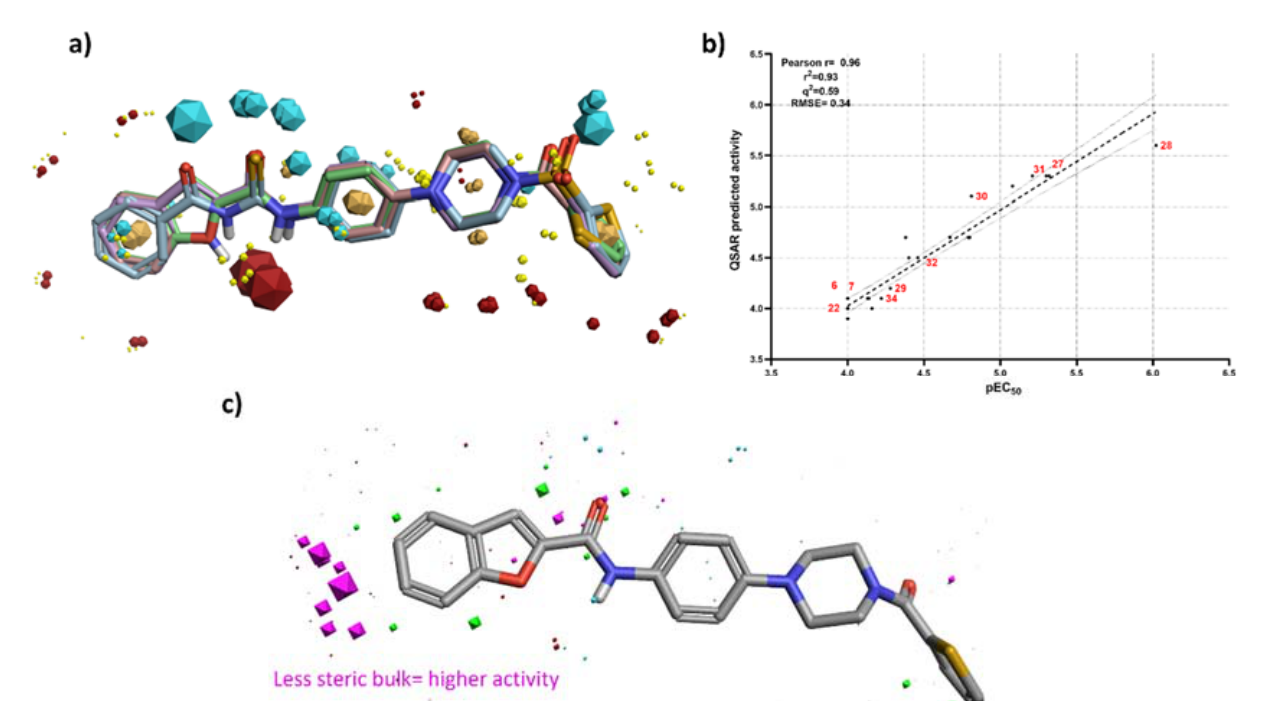
Figure 4. 3D-QSAR results for human norovirus. ( a ) Pharmacophore template with the respective molecular field points generated using compounds 4, 27, 28 and 30; ( b ) Plot of experimental (expressed as pEC 50 ) vs. predicted activity of the 3D-QSAR model; ( c ) The visual representation of the coefficients and variance field points modulating the bioactivity in the derived 3D-QSAR model.